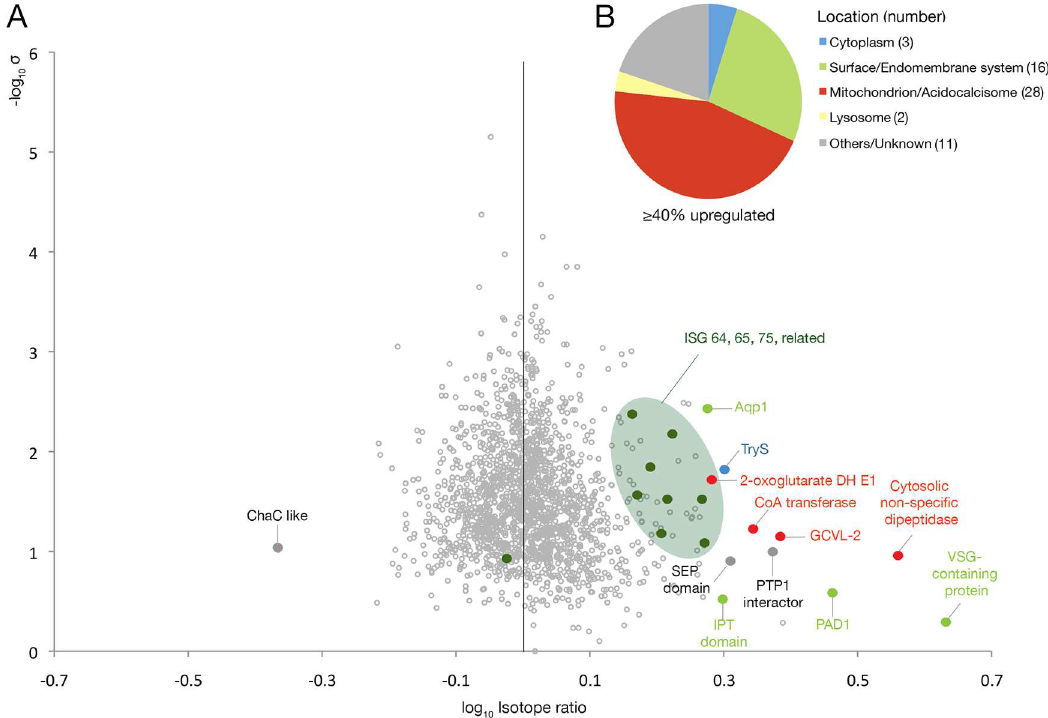
Fig 7. Quantitative proteomics by SILAC identifies altered surfaceprotein expression mediated by exocyst knockdown. (A) Volcanoplot of protein abundance changesat 36h post Sec15 RNAi induction. -log 10 transformed SILAC ratios are plotted against -log 10 transformed standard deviation. Data points representing protein groups significantlyaltered after 36 hours are labeled;ISG65 and ISG75 paralogsin dark green, other potentialsurface proteins in light green, mitochondrial proteins in red, cytoplasmic proteins in blue, lysosomal proteins in yellow, others in grey. AQP1: Aquaporin1, TryS: trypanothione synthetase; PTP1 interactor: Protein-tyrosine-phosphatase1-interacting protein; PAD1: Protein associatedwith differentiation 1; CoA transferase: Succinyl-coA:3-ketoacid-coenzyme A transferase; GCVL-2: Dihydrolipoyl dehydrogenase. (B) Predicted cellularlocalisation of proteins upregulated in Sec15 RNAi cells 36h post inductionas reportedby GO terms or as predictedby TMHMM2 for trans- membrane domainsand PredGPI for GPI- anchor additionC-terminal signal sequences[89, 90]. Numbersof proteins in each category are in